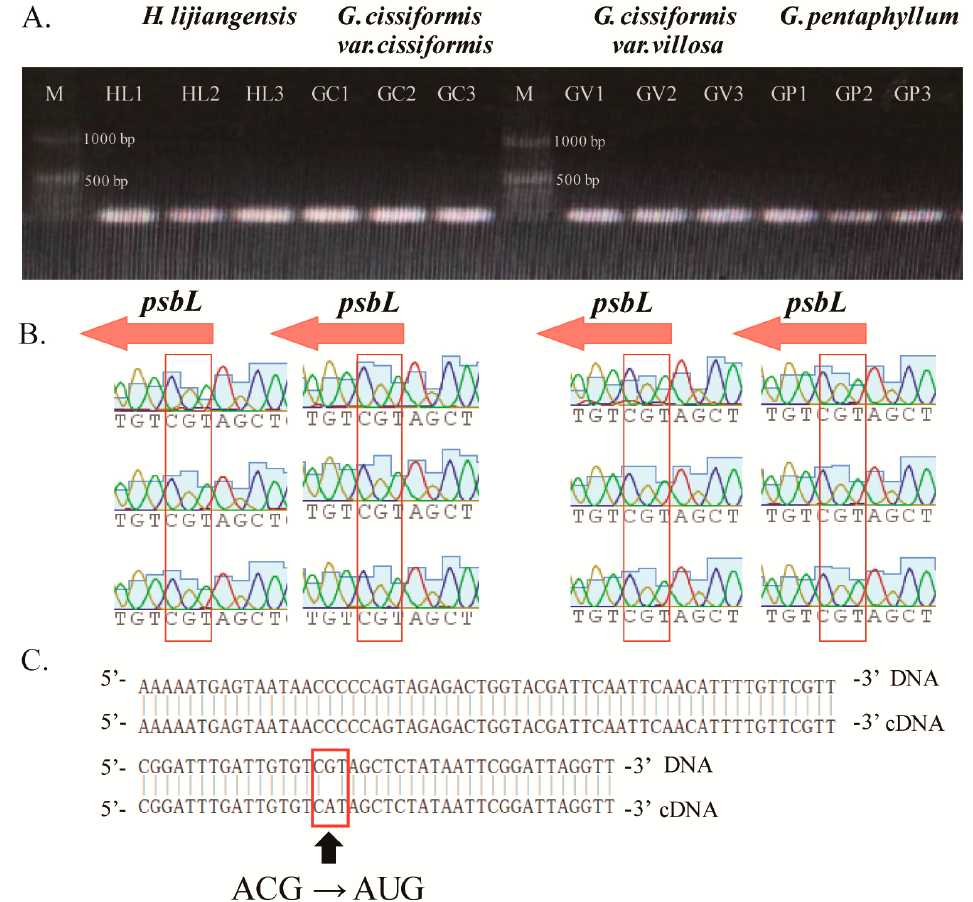
Figure 7. Result of unconventional initiation codon. ( A ) The PCR products electrophoresed in 1% agarose gel; ( B ) The PCR products sequences including start codon of gene psbL ; ( C )Blast results of sequence fragment of G. pentaphyllum including the start codon of psbL in the published transcriptome dataset.